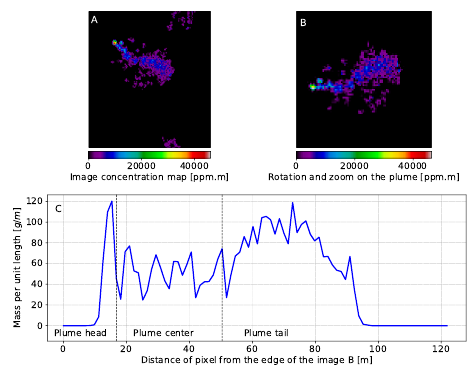
Figure 6. A : Concentration map of the entire image (in ppm.m) for HySpex acquisition. B : Concentration map after a rotation of 45 ◦ and a zoom on the plume. C : Mass per unit length (in g/m) along the plume (in m)